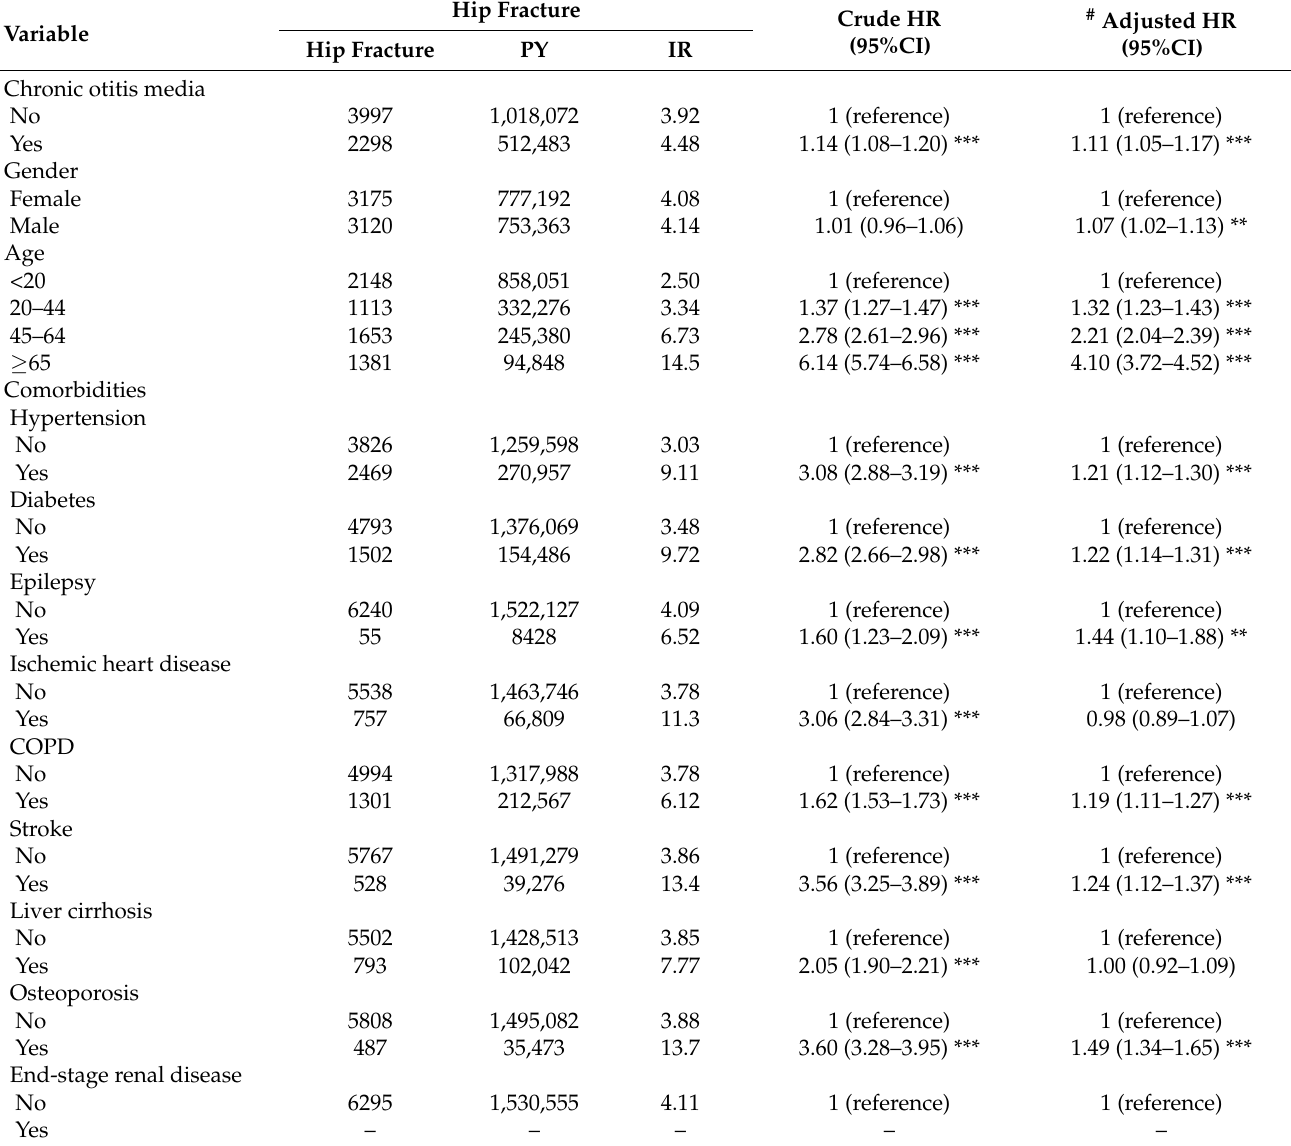
Table 2. The incidence density of hip fracture stratified by the history of chronic otitis media, gender, age, and